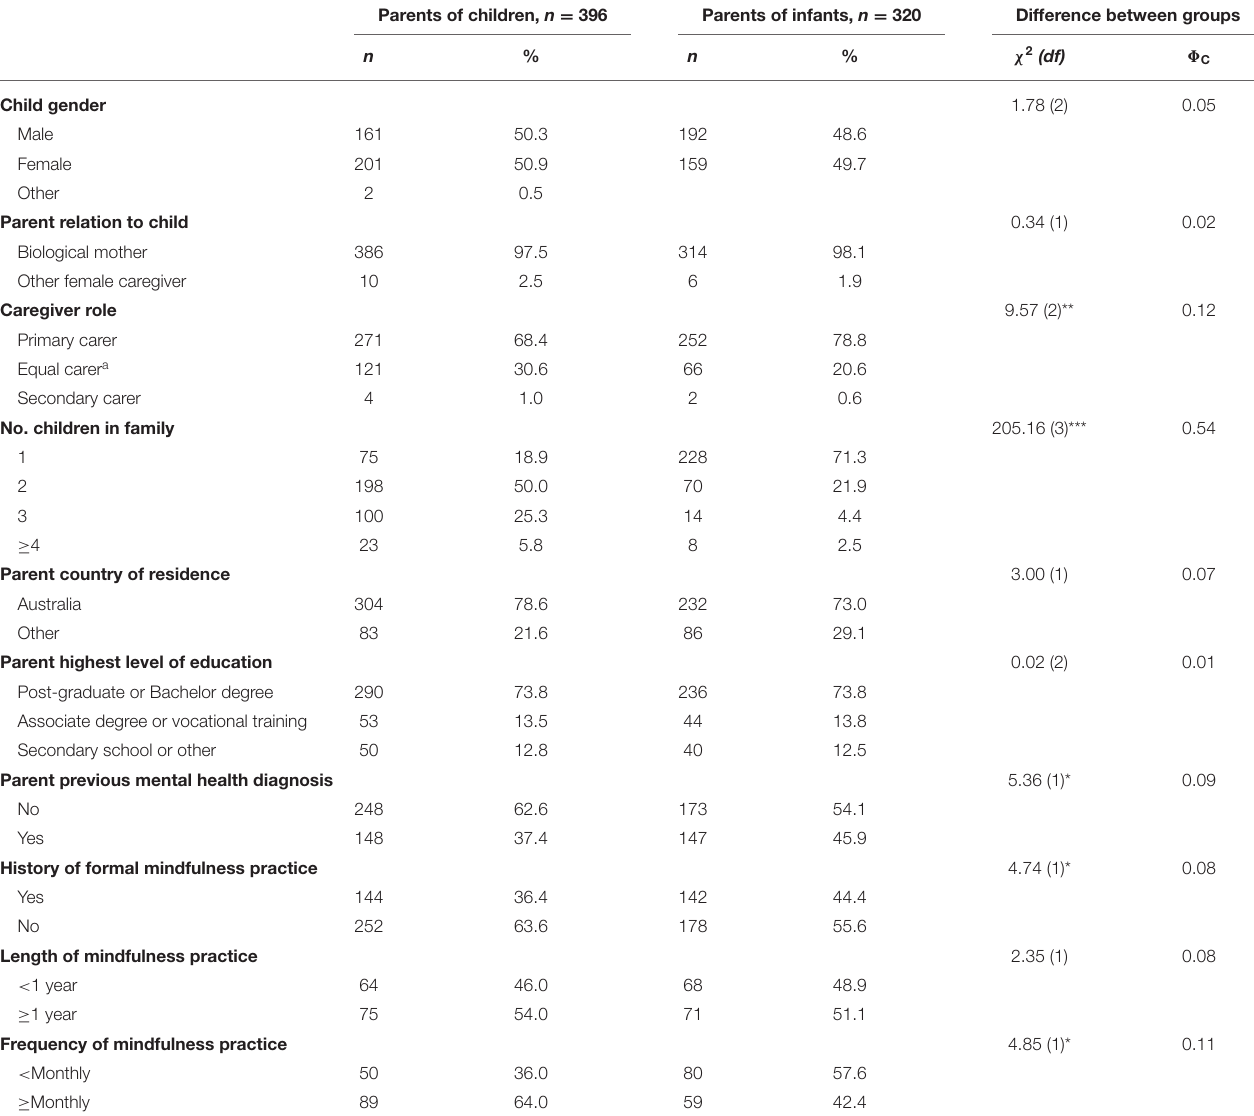
TABLE 1 | Sample characteristics ( N = 716). Parents of children, n = 396 Parents of infants, n = 320 Difference between